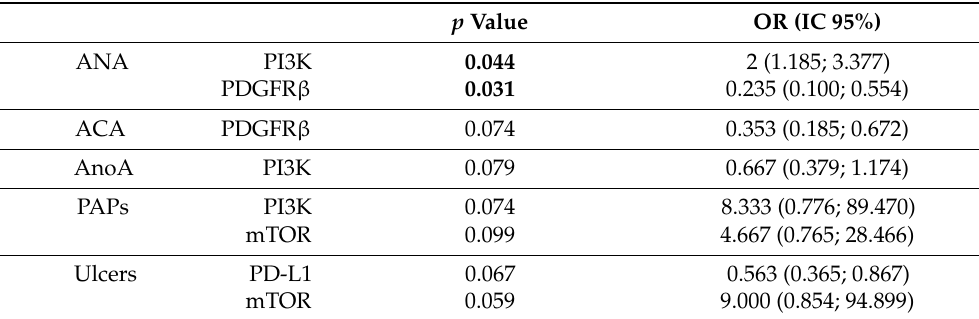
Table 2. Significant correlations between main SSc features and some BC immunoistochemical aspects.